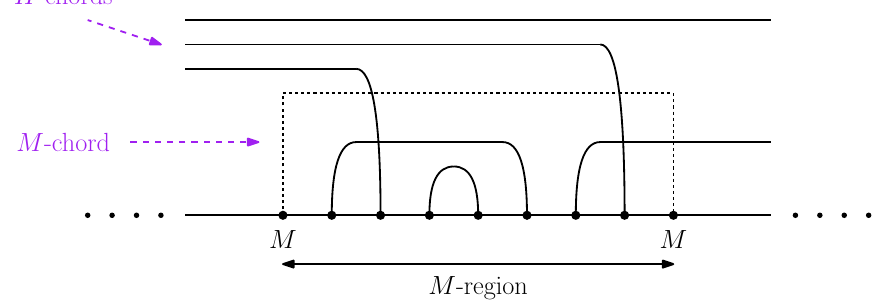
Figure 6. A subregion consisting of two M nodes which are contracted.